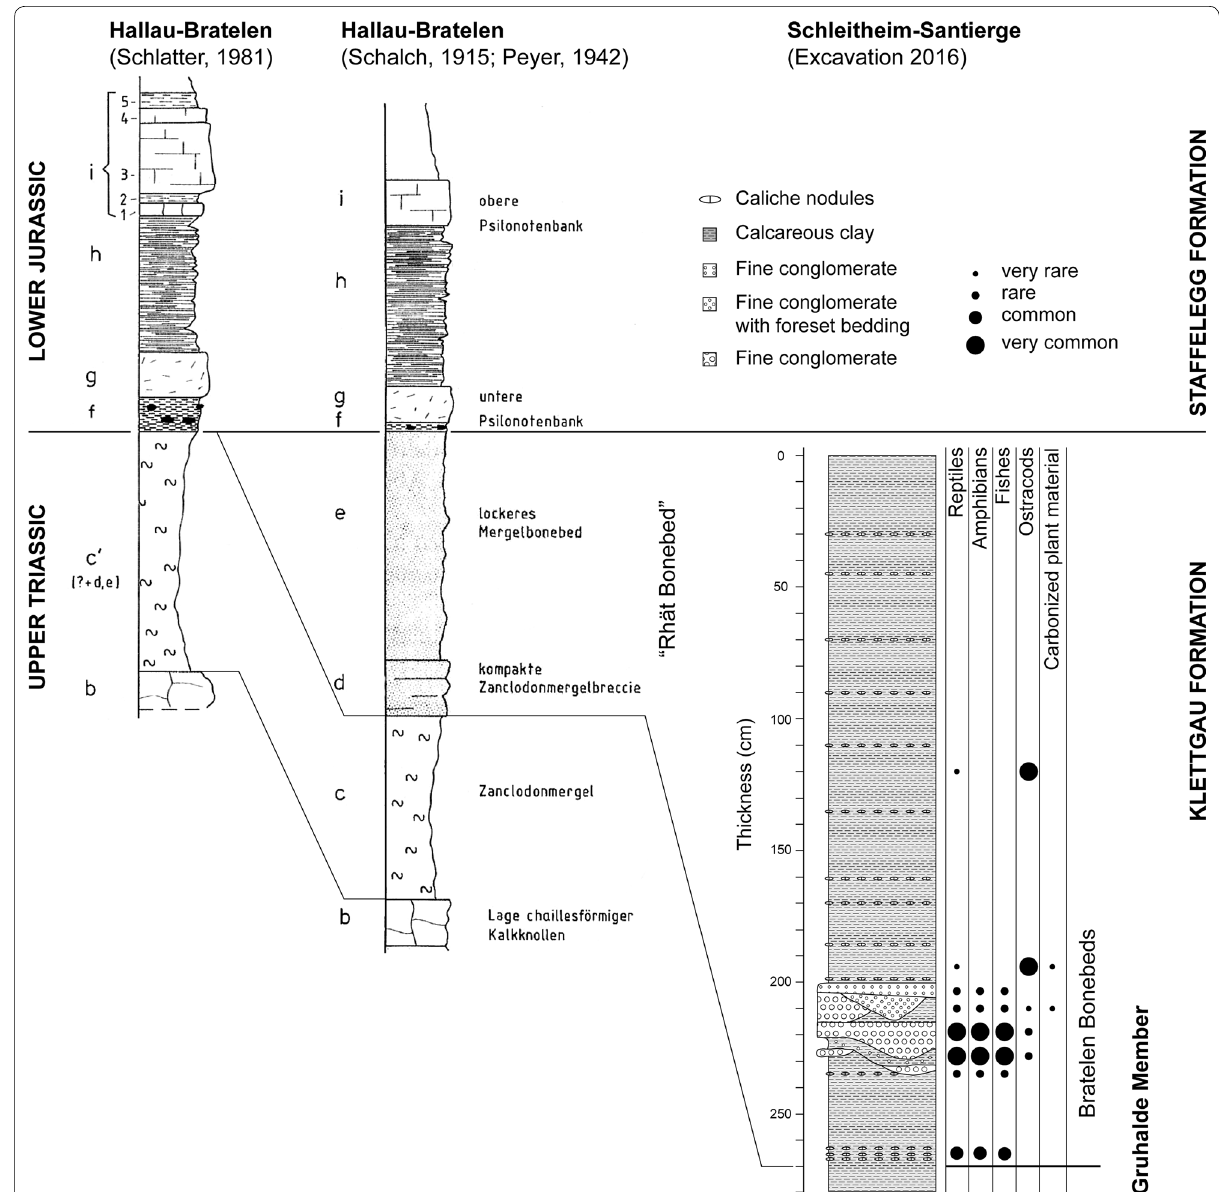
Fig. 2 Correlation of Upper Triassic to Lower Jurassic sections in the localities Hallau-Bratelen and